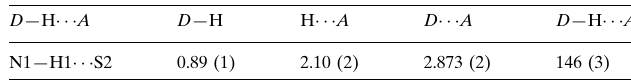
Hydrogen-bond geometry (A˚ , (cid:2)